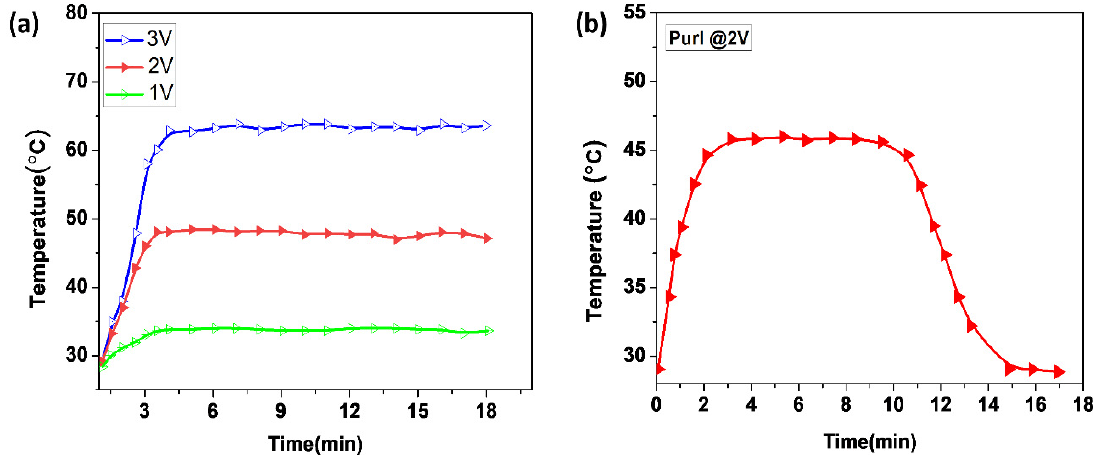
Figure 7. The temperature change of purl stitch ( a ) under 1 V to 3 V, ( b ) steadiness of temperature at 2 V and with time.